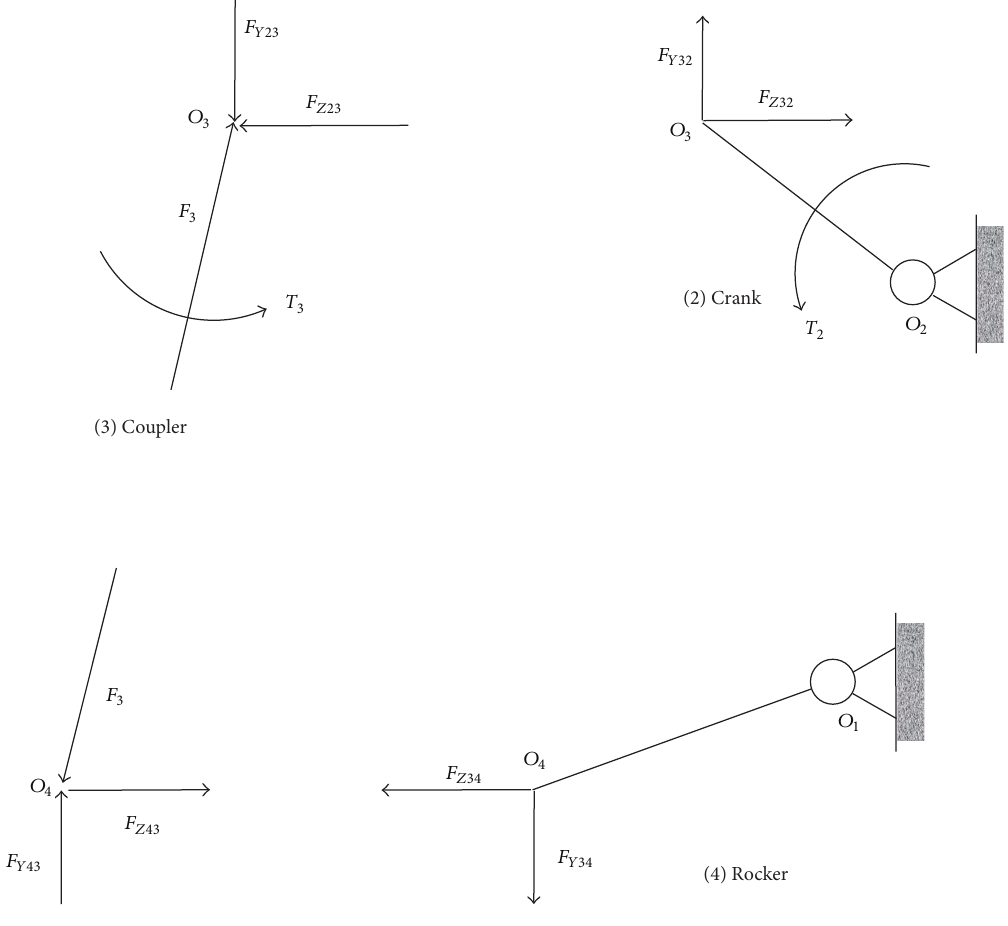
Figure 3: Free-body diagrams of the crank, the coupler, and the rocker.